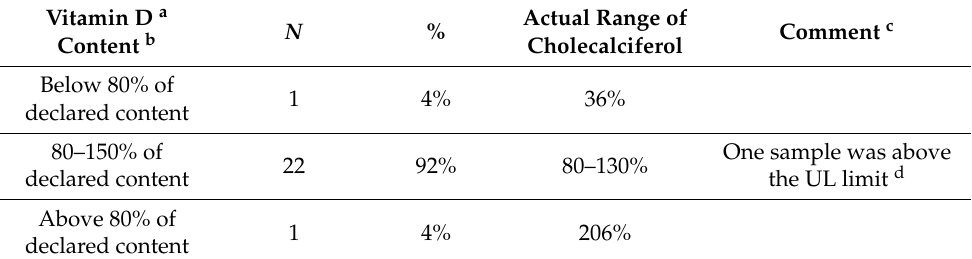
Table 2. Summary of results of laboratory quantification of vitamin D in sampled food supplements and conformity with regulatory requirements ( N = 24).